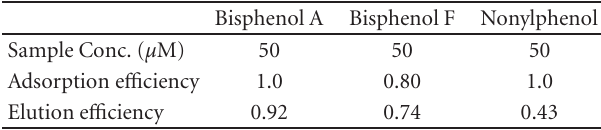
Figure 2: Chemical structures of bisphenol A, bisphenol F, and nonylphenol. Table 1: Selectivity of MIP packed column to bisphenol